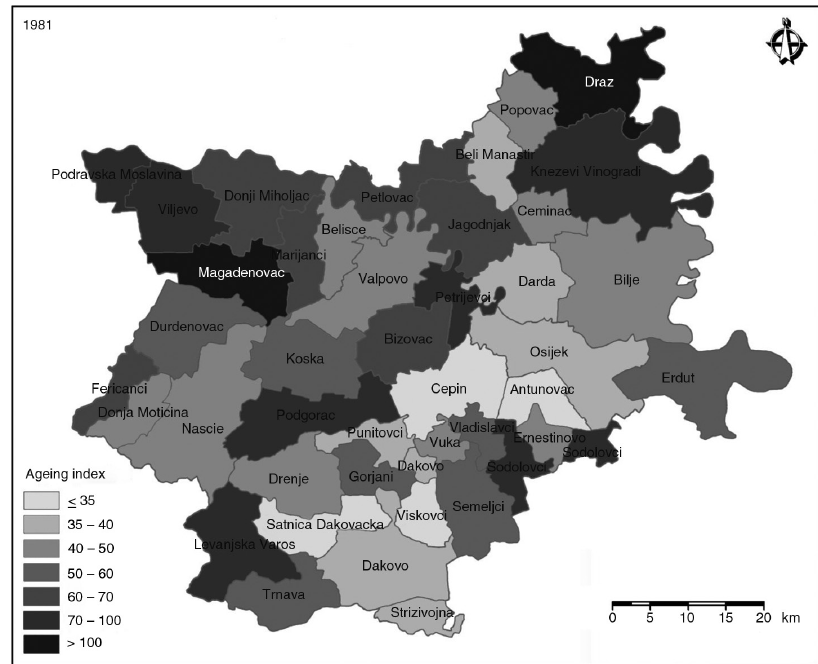
Figure 4. Ageing index of the municipalities in 1981. Source : CBS